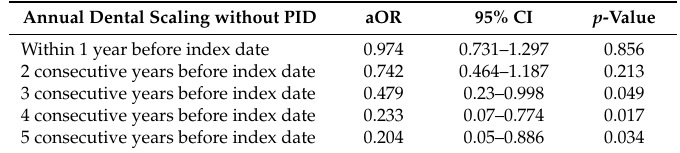
Table 3. Sensitivity analysis of case-control model for Parkinson’s